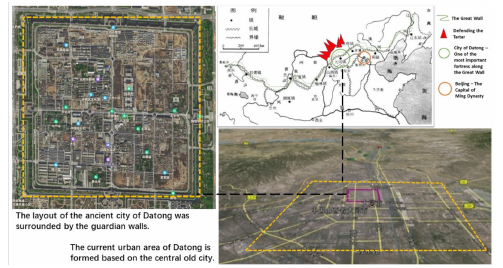
Figure 3. Location of the study area (The Chinese characters in the maps are all place names). Source: Author.